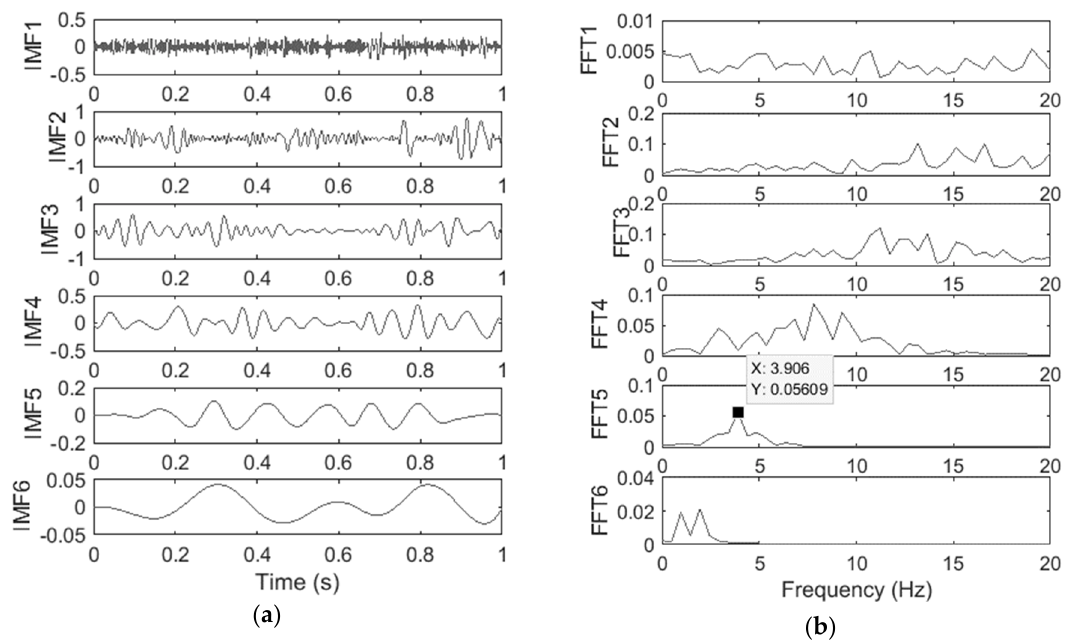
Figure 6. ( a ) IMF components and ( b ) their FFT spectra in the presence of a road profile.